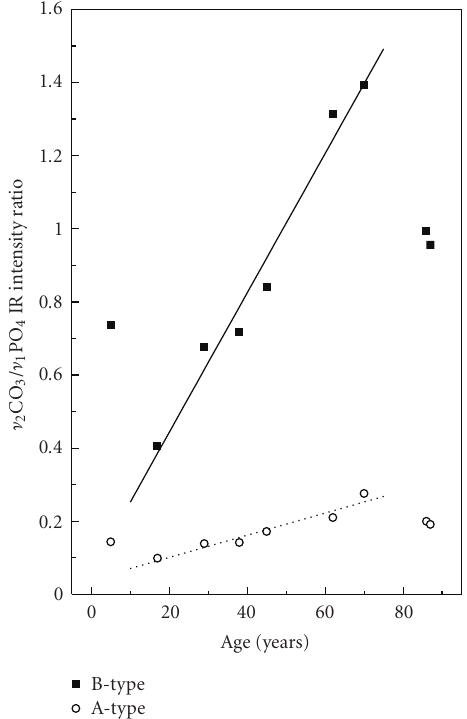
Figure 9: Ratios of the IR intensities of the ν 2[B] (880cm − 1 ) and ν ν − 1 ) CO − 1 ) mode. 2[A] (870 cm 3 modes to the 1 PO 4 (960 cm Squares mark the B-type and open circles the A-type carbonate substitutions. An estimate of the relative carbonate content in human dental apatite as a function of the tooth-age is provided by these ratios. The lines are guides to the